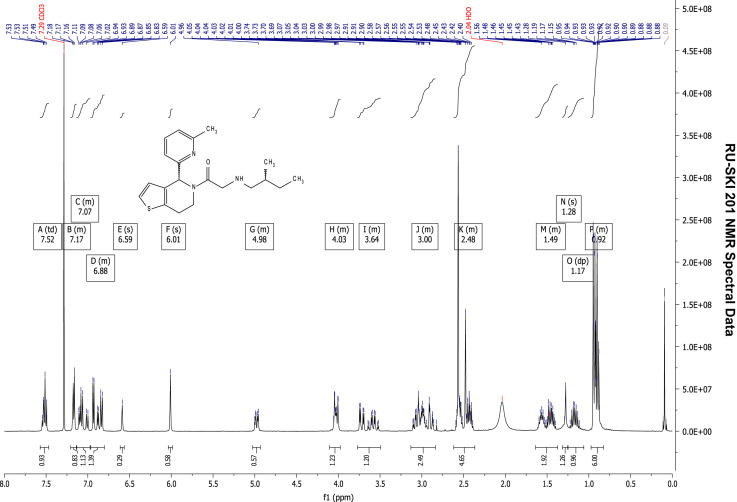
1H NMR (400 MHz, CDCl3) of RU-SKI 201
(9d).